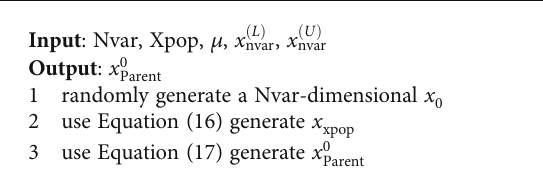
Algorithm 1: Logistic chaotic map initialization population.